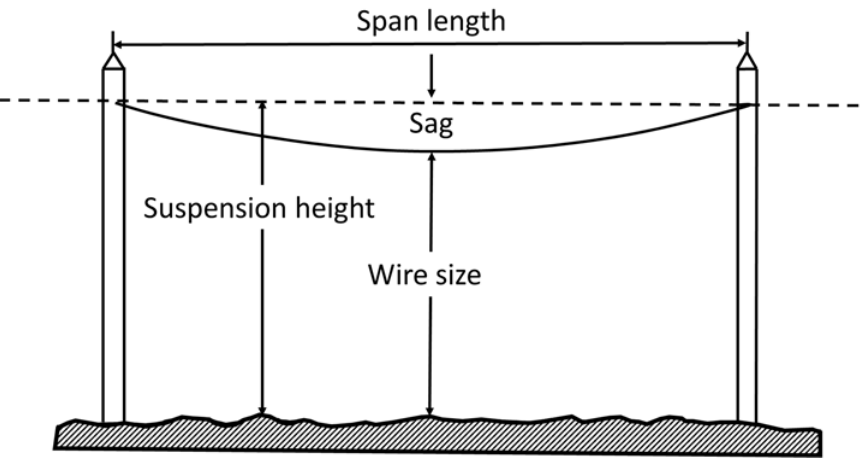
Figure 23. Scheme of the main terminology of the power line. The wires are subjected to mechanical loads directed vertically (self-weight and ice) and horizontally (wind). Under the action of loads, tensile stresses occur in the metal [38]. A single load is a load that falls on 1 m of wire length. A specific unit load is a mechanical load uniformly distributed along the wire span, which falls on 1 m of the length of the wire and 1 mm 2 of the wire cross-section [39]. These loads are calculated under the condition that the load is uniformly distributed and there are no wind